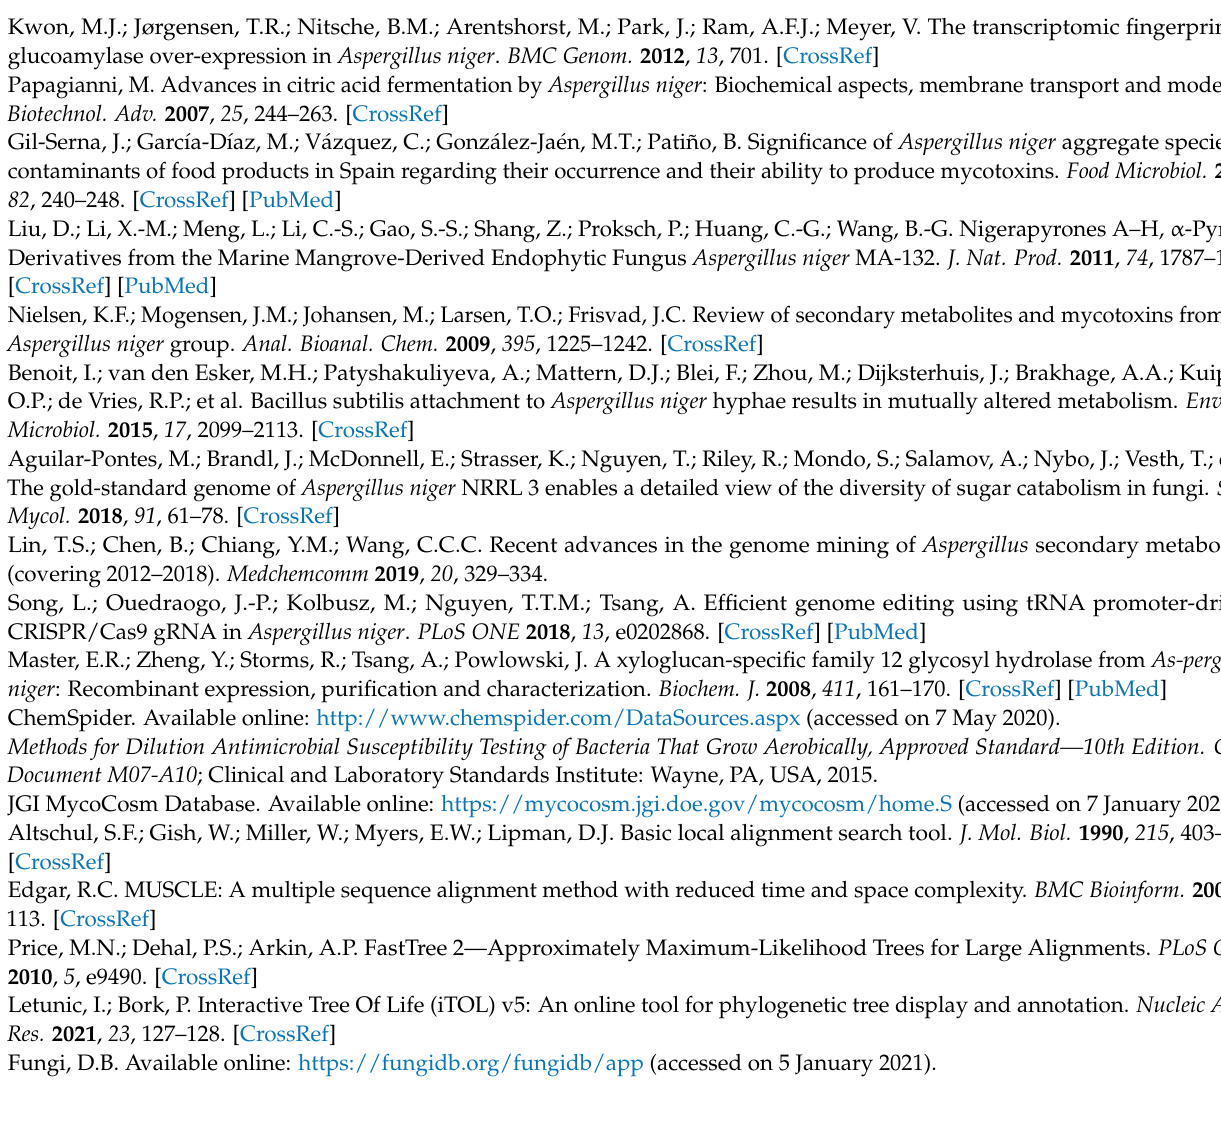
niger strains. Figure S1. Verification of NRRL3_00042 over-expression strain. Figure S2. Verification of NRRL3_00042 and NRRL3_00036 expression in NRRL3_00042 OE and CSFG_7003 by RT-PCR. Figure S3. Verification of NRRL3_00036 deletion strain. Figure S4. Escherichia coli JW5503–1 and Staphylococcus aureus N315 inhibition